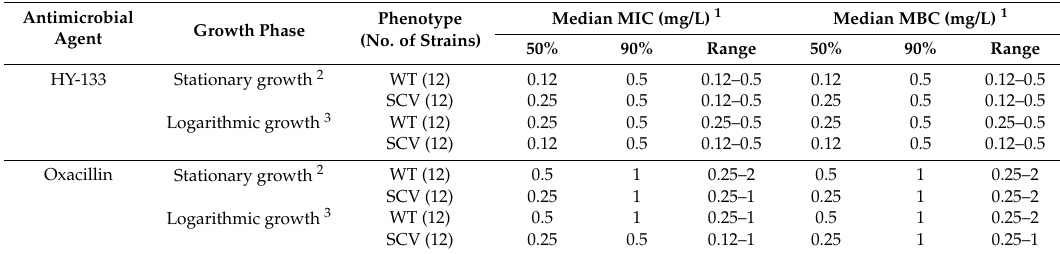
Table 1. Antimicrobial activities of HY-133 and oxacillin for 12 clinical wild type (WT) isolates compared with their clonally identical small-colony variants